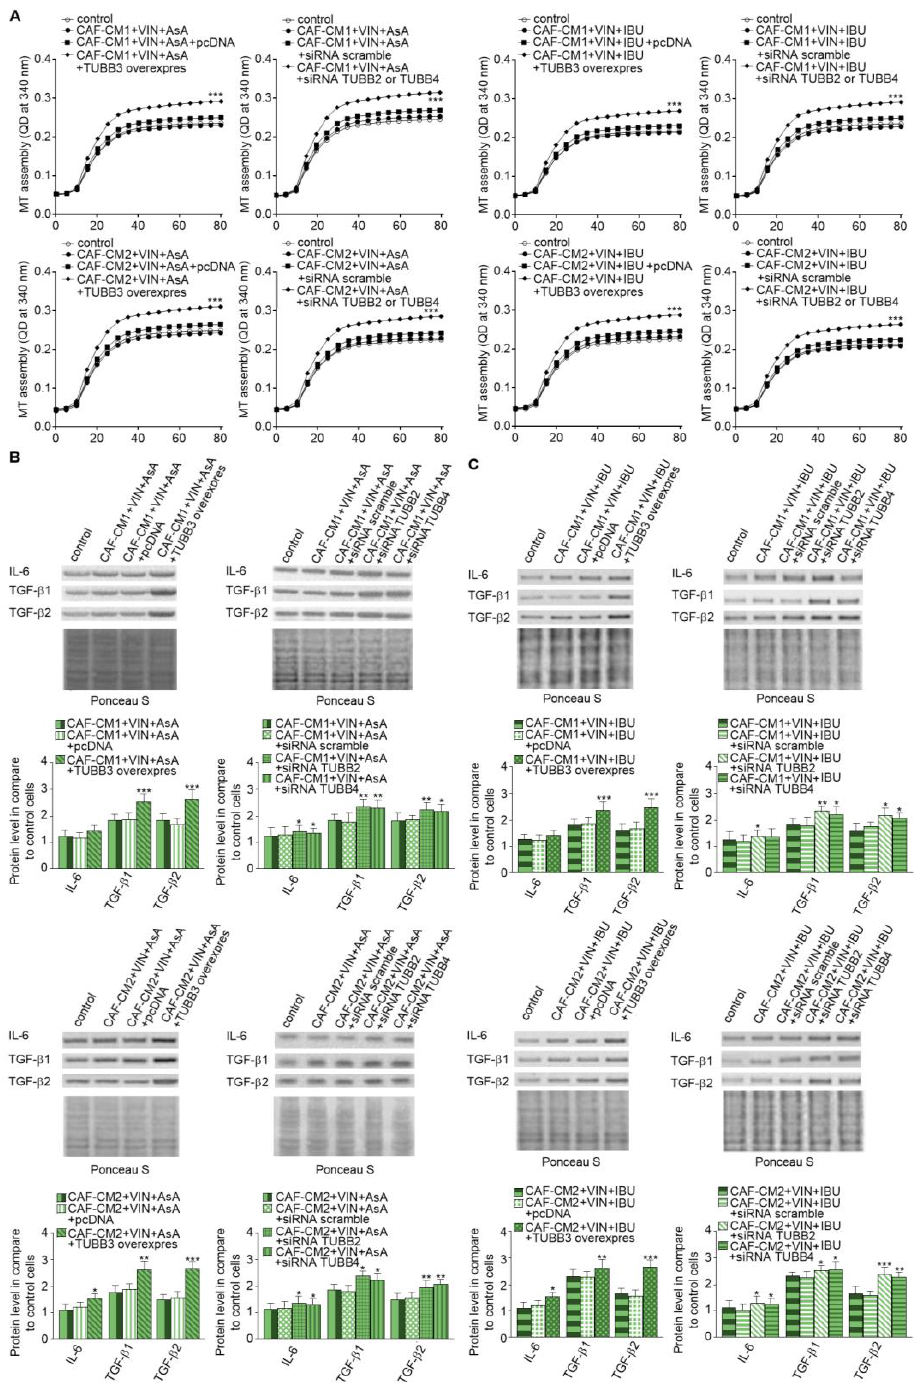
Figure 7. Modulation of β -tubulins level alters IL-6 and TGF- β s secretion through regulation of microtubules polymerization. The polymerization ability was analyzed in microtubules isolated from CAF-like cells maintained in CM colon cancer cells treated with vincristine and one of the NSAIDs—IBU or AsA where TUBB was overexpressed (TUBB3 overexpres) and TUBB2 or TUBB4 were silenced (siRNA TUBB2 or siRNA TUBB4) ( A ). Next, the level of TGF- β s (TGF- β 1 and TGF- β 2) and IL-6 was analyzed in medium from cells treated with NSAIDs (AsA or IBU) by Western blot. The results are provided as means ± SD ( n = 3); * p < 0.05, ** p < 0.001, *** p < 0.005. The blots are representative of three independent experiments ( B , C ). As the control, an empty vector (pcDNA) or nonspecific fragments (siRNA scramble) were used. As the control of loading, the Ponceau Staining was